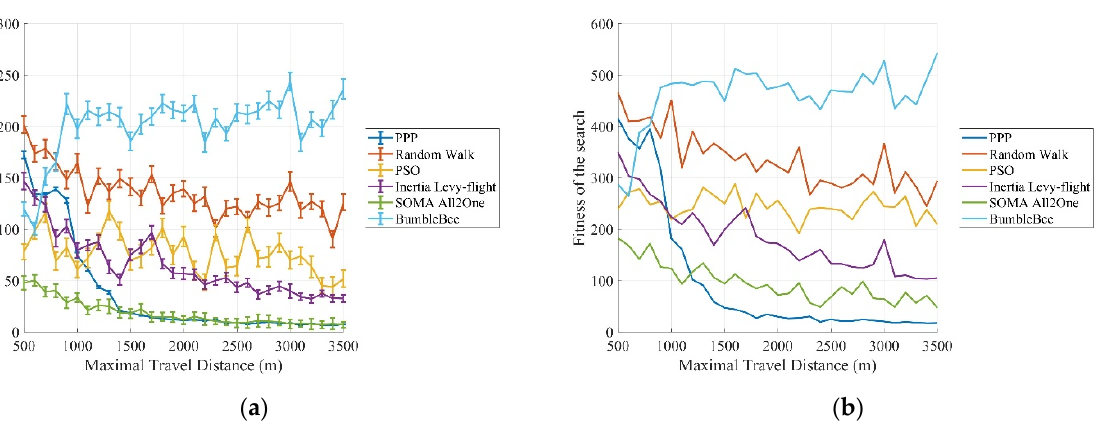
Figure 25. Median performance ( a ) and fitness ( b ) of different search strategies for different maximal travel distance of the autonomous underwater vehicles (AUVs).